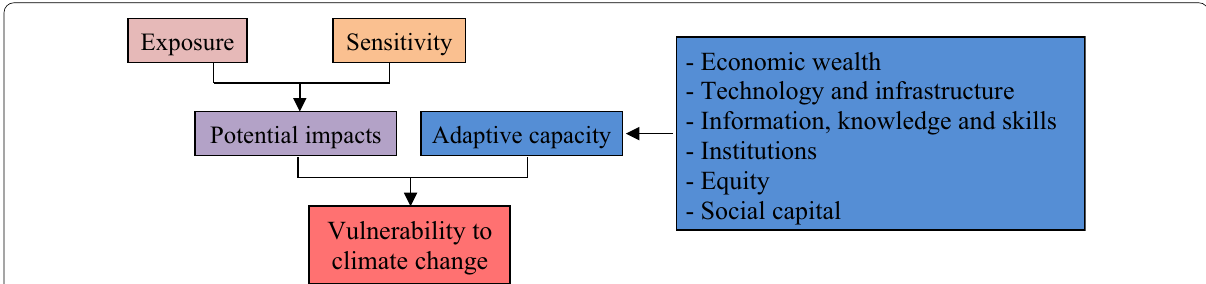
Fig. 1 Conceptualisation of vulnerability to climate change in the IPCC Third Assessment